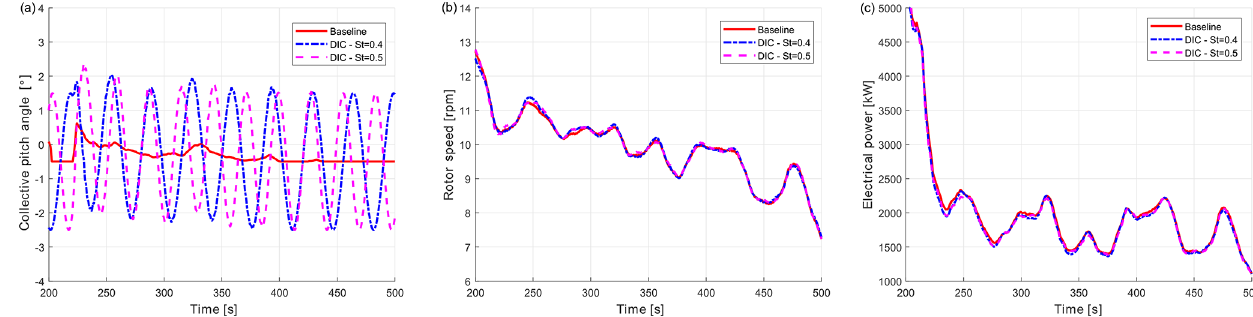
Figure 6. Comparison of pitch activity (a) , rotor speed (b) and power (c) between baseline (solid red) and DIC controlled with St = 0 . 4 (dash–dotted blue) and St = 0 . 5 (dashed magenta) turbine for NTM class A at 9ms − 1